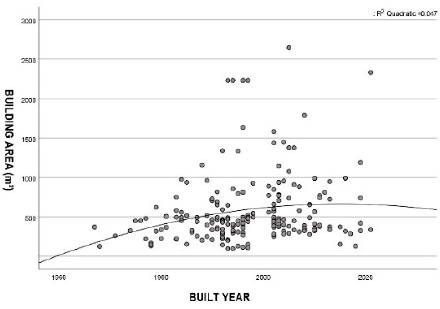
Figure 8. Descriptive analysis: Site area, Building area, and Site width and depth.